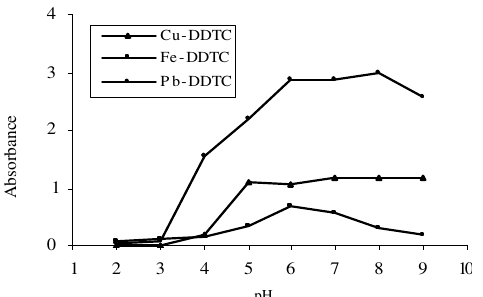
Figure 1. Effect of pH on the absorbance of metal-DDTC complex; 5 mg L -1 Cu, Fe and Pb ( n = 6)